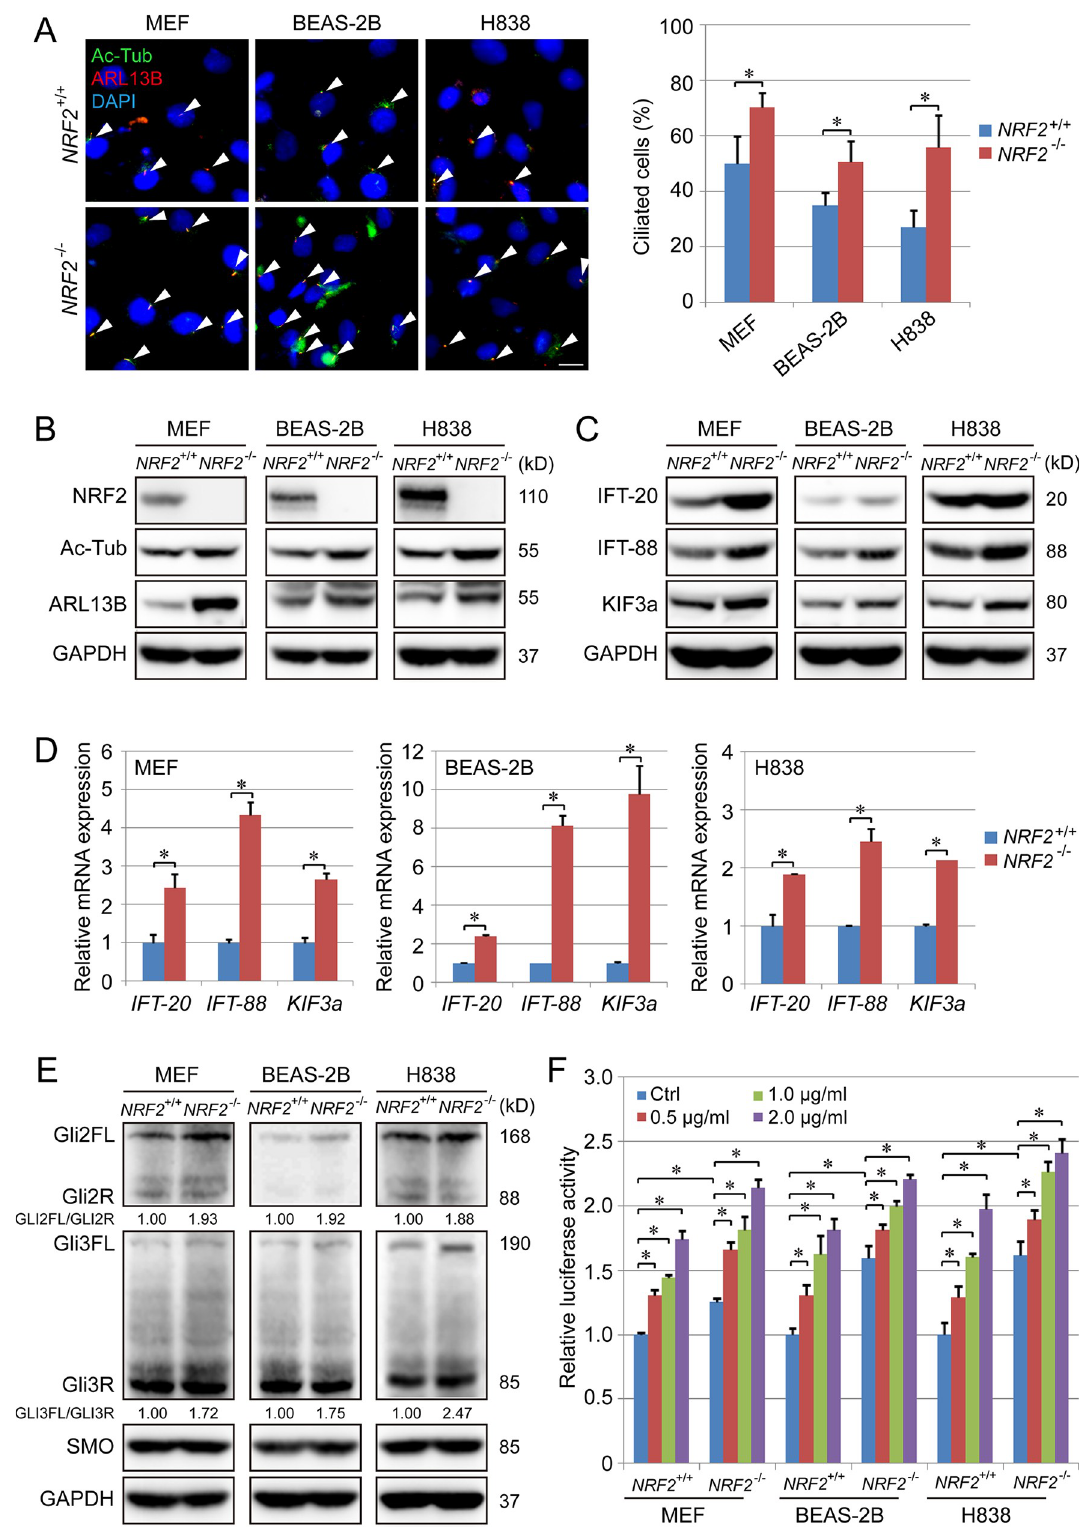
Fig 1. NRF2 deletion enhances ciliogenesis and Hh signaling. (A) IF for Ac-Tub (green) and ARL13B (red) in NRF2 +/+ and NRF2 − / − MEFs, BEAS-2B, and H838 cell lines. Ciliated cells (%) represent the percentage of Ac-Tub/ARL13B-positive cells normalized to